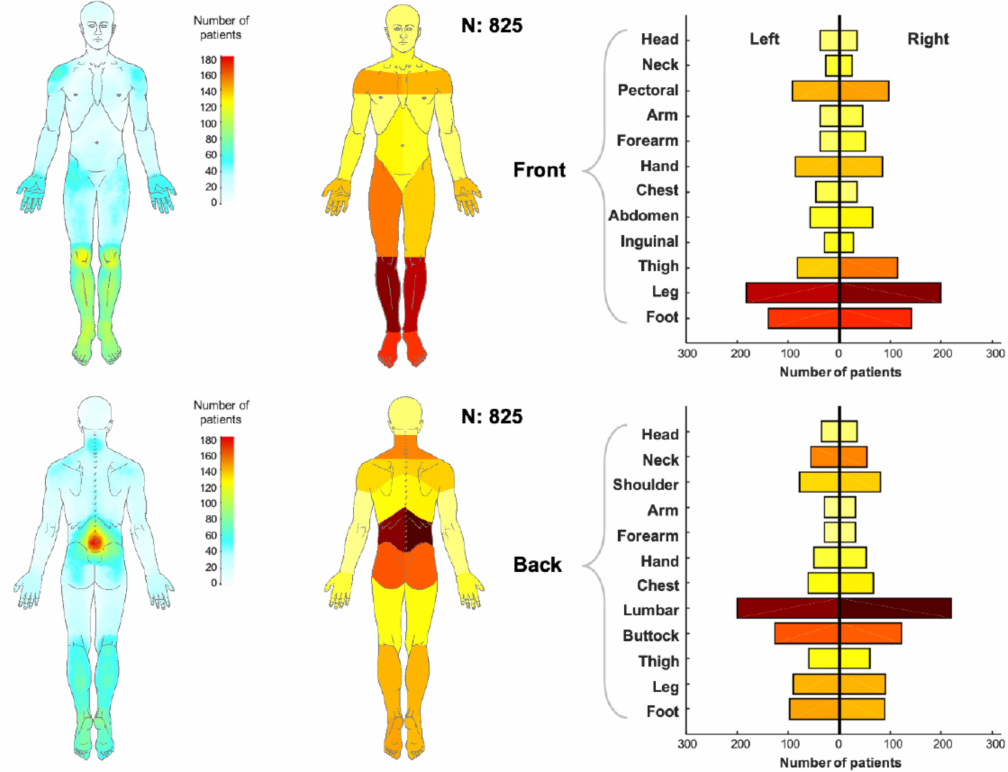
Figure 1. Topographic pain maps, on the left side, have been generated to highlight the most frequently reported pain locations for both the dorsal and ventral views. The color grid indicates the number of individuals that reported pain in that specific area. Red and yellow colors represent the most frequently reported areas of pain. Pain location maps, on the right side, indicate the number of persons who reported pain in a particular anatomical region. The regions of the body have been color coded as displayed on the left side of the column chart. The presence of the pain in a body region was confirmed when at least 10% of the body region area (corresponding to the number of pixels being greater than 60) was covered in the pain